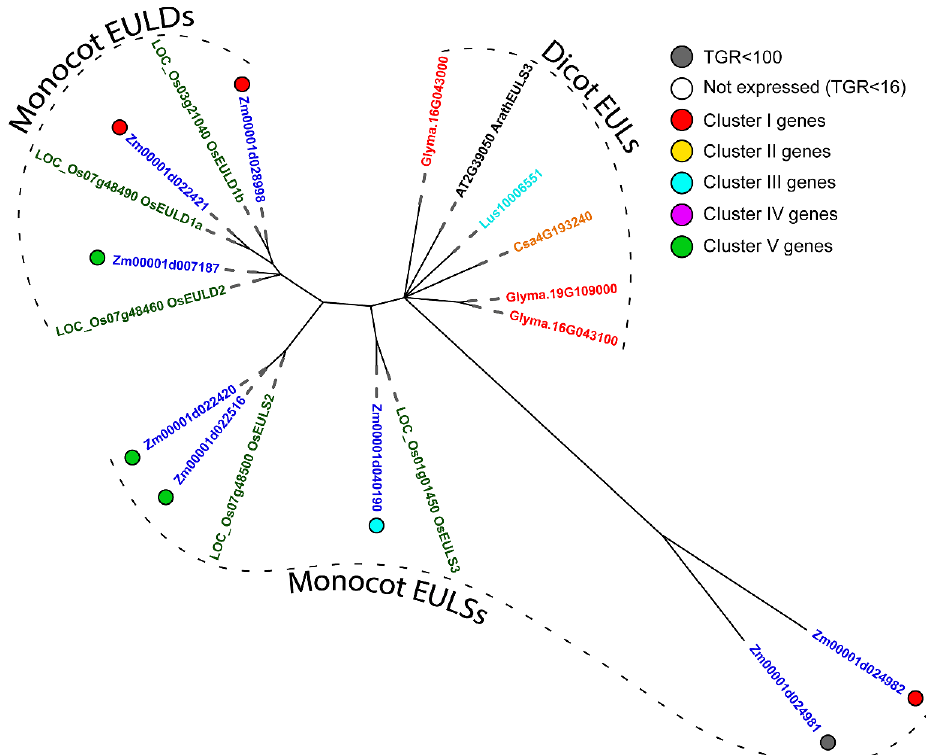
Figure 2. Phylogenetic dendrogram of Euonymus europaeus lectin (PF14200) family members of A. thaliana (gene names are given in black font), Z. mays (blue font), G. max (red font), O. sativa (green font), L. usitatissimum (cyan font) and C. sativum (orange font). The colored dots next to Z. mays genes denote the character of expression: white—genes with no expression (TGR value less than 16 in all samples); gray—genes with a TGR value less than 100 in all samples; red—genes from cluster I, expression decreased from meristem and root cap zones to late elongation; yellow—genes from cluster II, expression peaks in the early elongation zone; blue—genes from cluster III, high expression from early to late elongation; purple—genes from cluster IV, expression increased in the root cap and also increased from meristem zone to late elongation; green—genes from cluster V, highest expression in the late elongation zone. Only branches with ultrafast bootstrap support values greater than 90 are